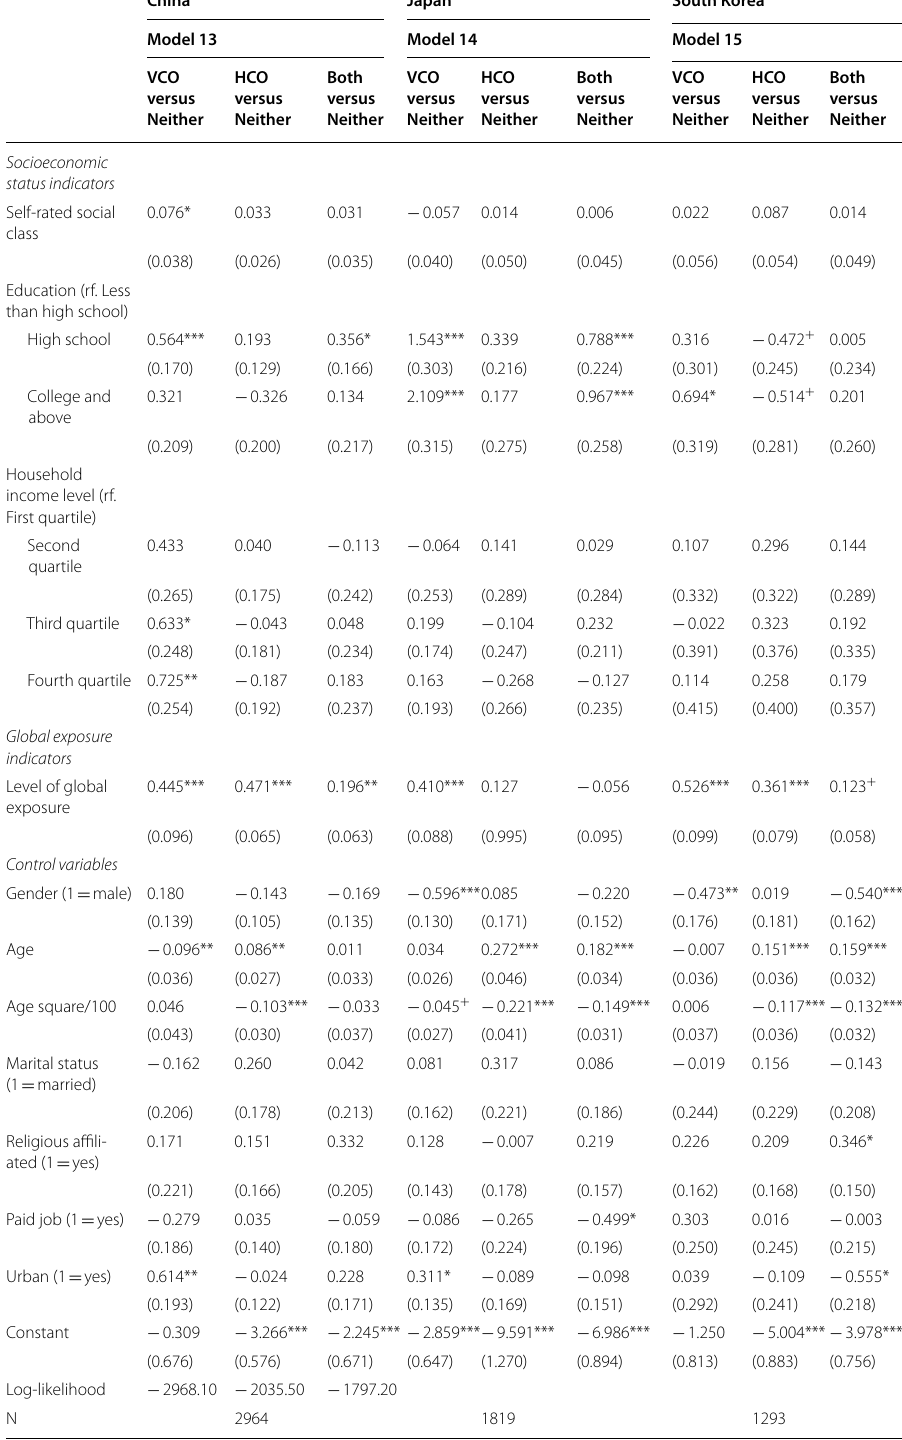
Table 5 Multinominal logit regression models on types of cultural